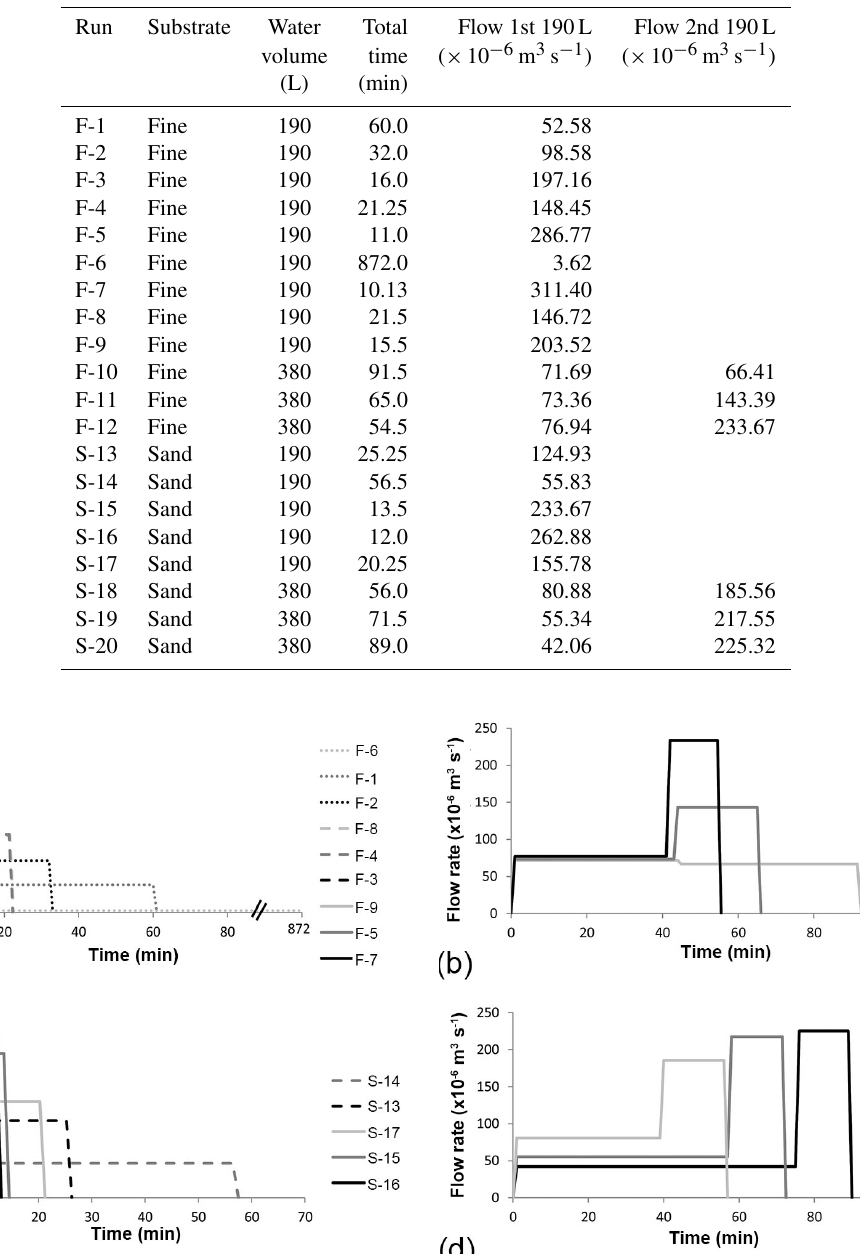
Table 1. Experimental run parameters.